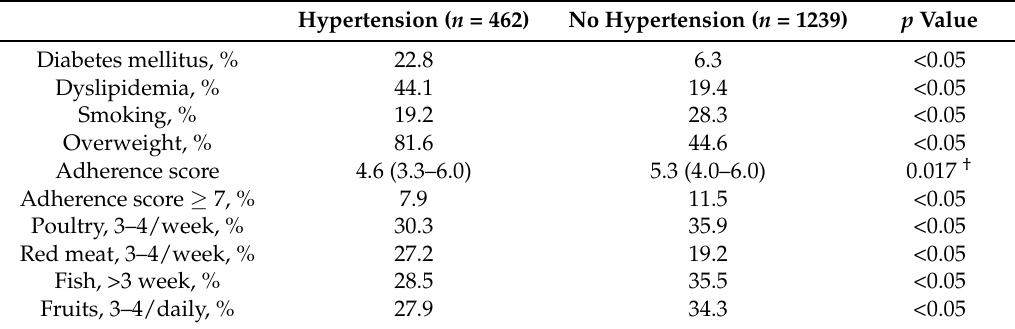
Table 6. Prevalence of hypertension according to other cardiovascular risk factors and main dietary patterns in the entire